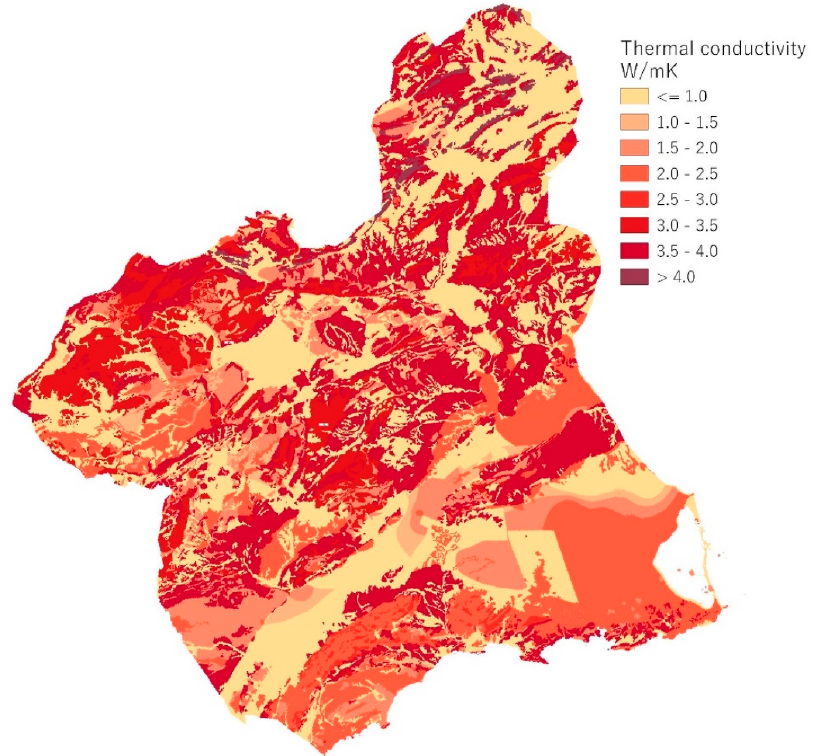
Figure 5 . Map of thermal conductivity in the Region of Murcia based on UNE 100715 —1